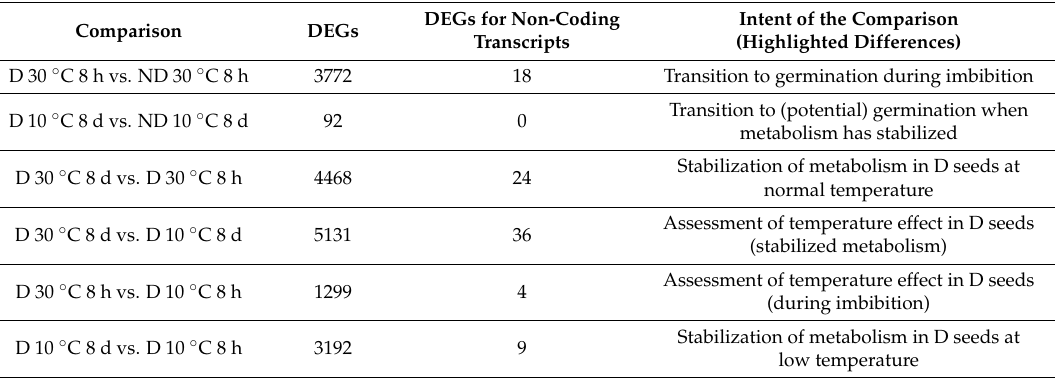
Table 3. Number of differentially expressed genes (DEGs) detected in imbibed